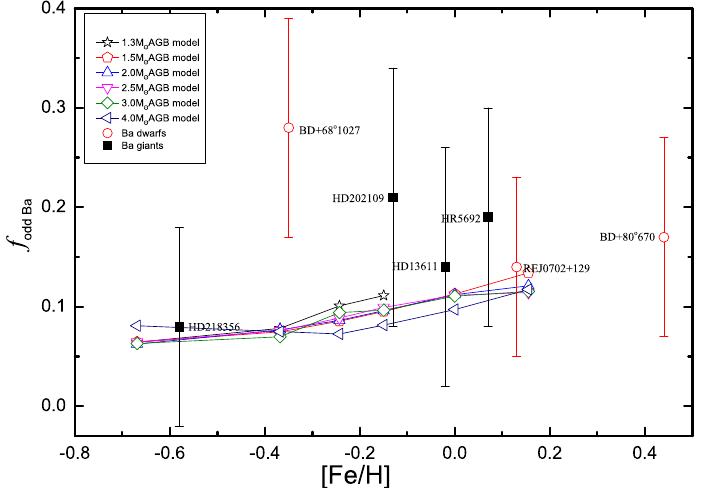
Figure 5. The Ba odd isotope fractions predicted by the AGB model versus [Fe/H] based on the FRANEC Repository of Updated Isotopic Tables & Yields (FRUITY) database, which provides the nucleosynthesis of AGB stars with different masses: 1.3, 1.5, 2.0, 2.5, 3.0, and 4.0 M (cid:12) , and with no initial rotation [59]. Our sample stars are also presented in the